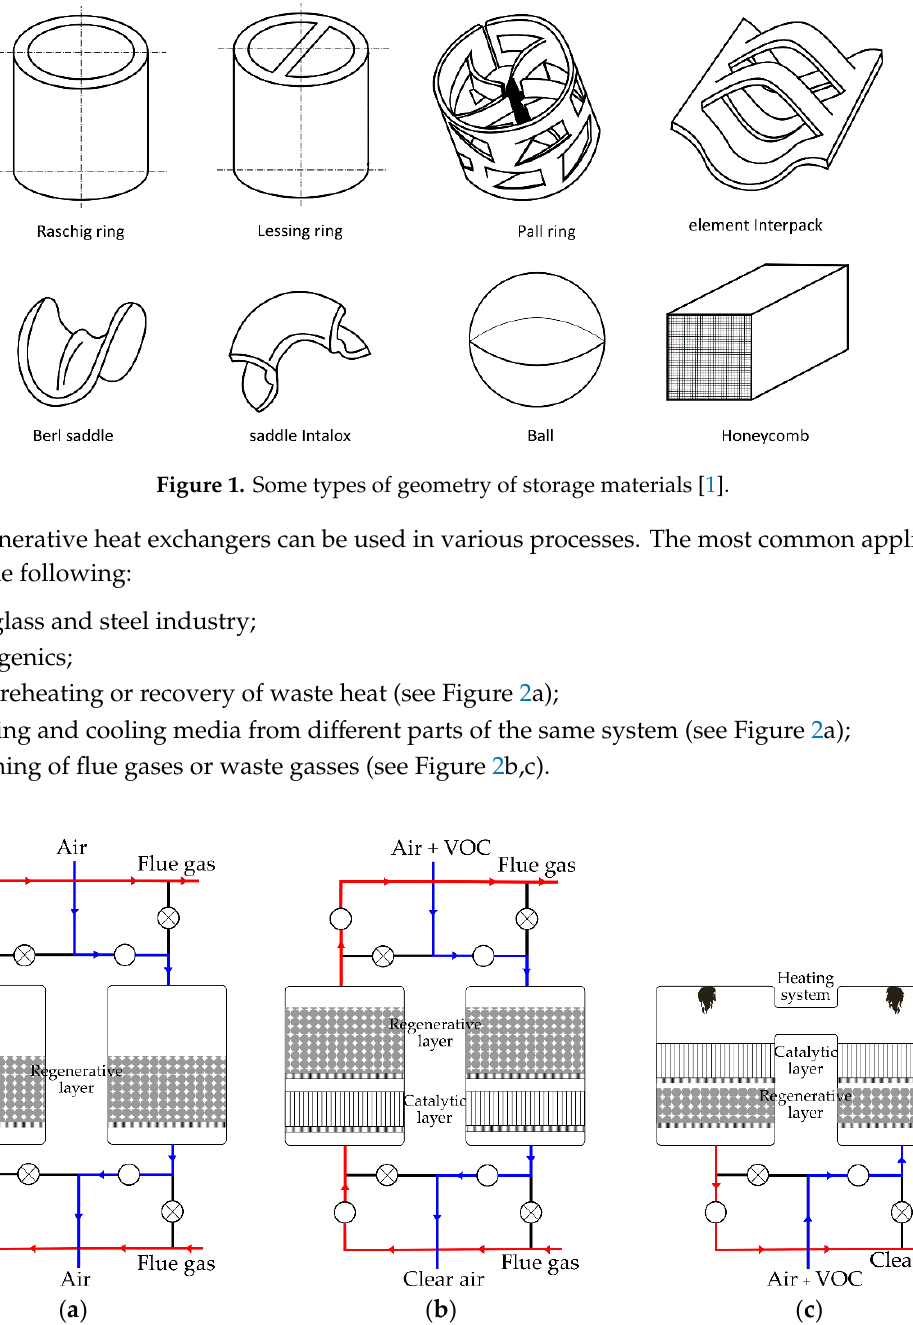
Figure 2. Possibilities of connection of regenerative heat exchanger: ( a ) connection of regenerative heat exchanger for heating or cooling media; ( b ) connection for cleaning of flue gases or waste gasses —option 1; ( b ) connection for cleaning of flue gases or waste gasses—option 2.